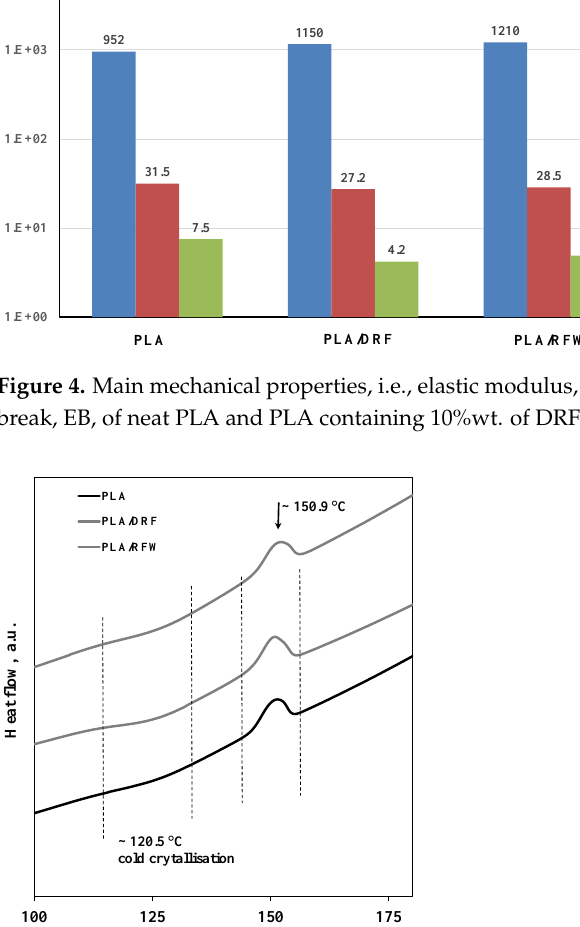
Figure 4. Main mechanical properties, i.e., elastic modulus, E; tensile strength, TS; and elongation at break, EB, of neat PLA and PLA containing 10%wt. of DRF and RFW.